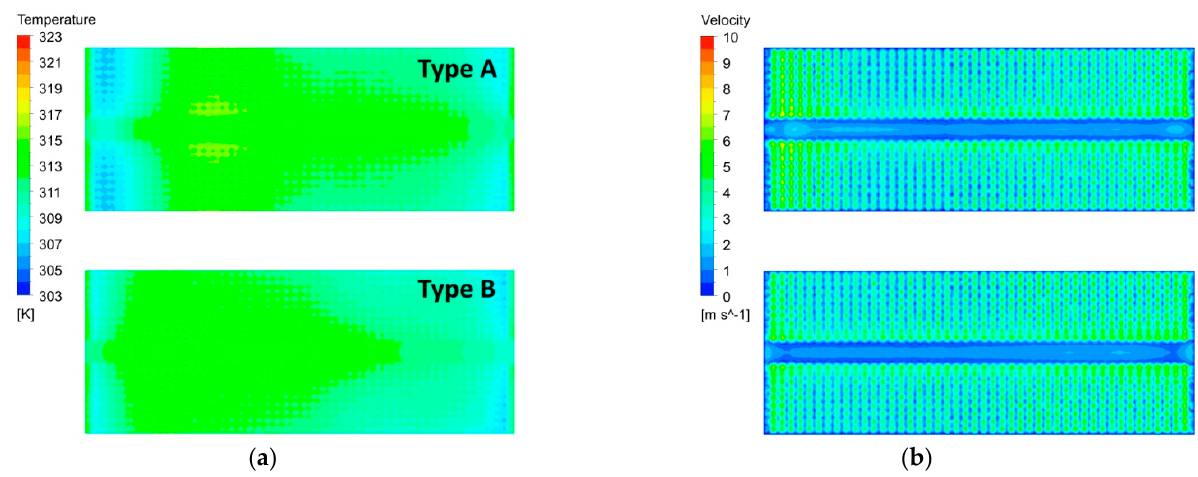
Figure 16. Temperature distribution and velocity profile on section area of PEMFC outlet in ( a ) Type A and ( b ) Type B.